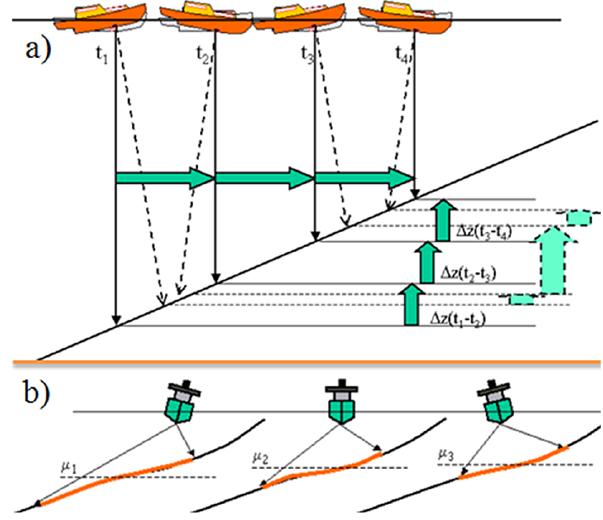
Figure 4. The effect of frontal (a) and dorsal (b) waves on data registration (Clarke,